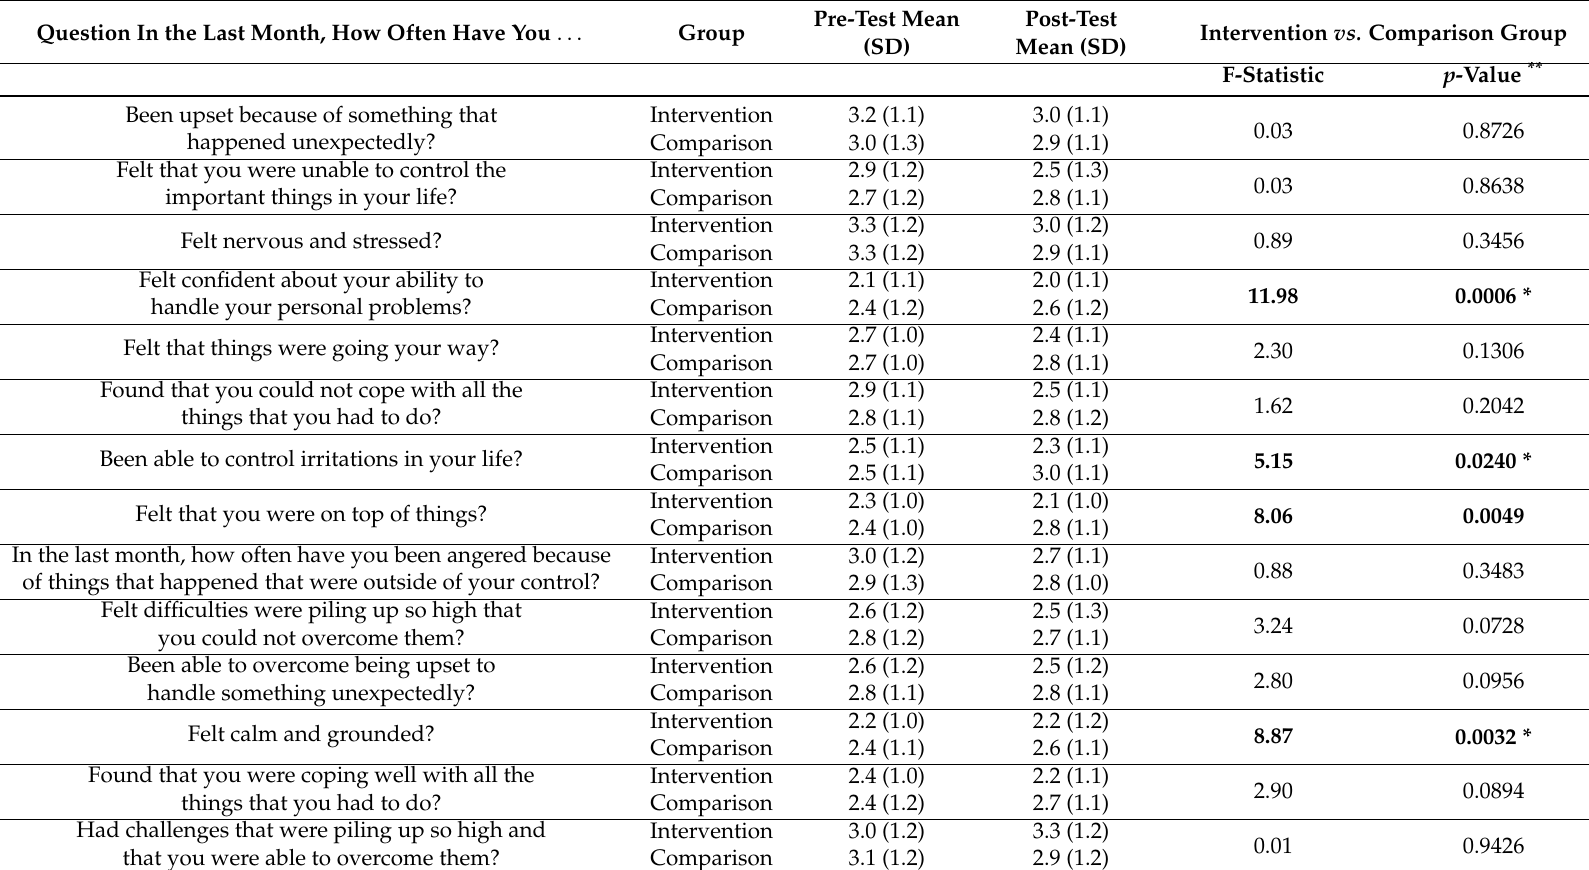
Table 4. Results of Generalized Linear Model Analysis of Group Differences in Perceived Stress Scale